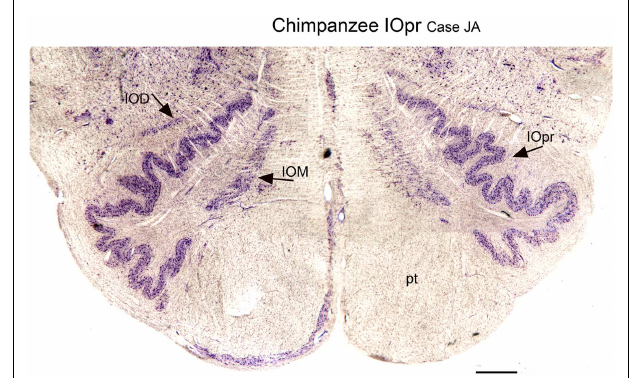
FIGURE 6 | Differences in the shape of the principal nucleus of the inferior olive on the left and right in the chimpanzee (CV) . IOD, dorsal nucleus of the inferior olive; IOM, medial nucleus of the inferior olive; IOpr, principal nucleus of the inferior olive; pt, pyramidal tract. Scale bar